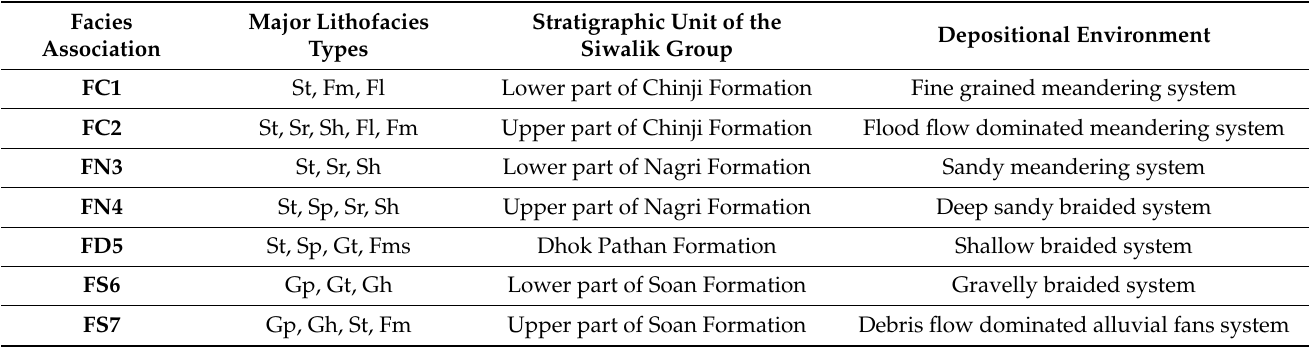
Table 1. Description and interpretation of the Siwalik Group facies association (FA) along Dadyal to Sehnsa area of Mirpur division, Pakistan (Modified after